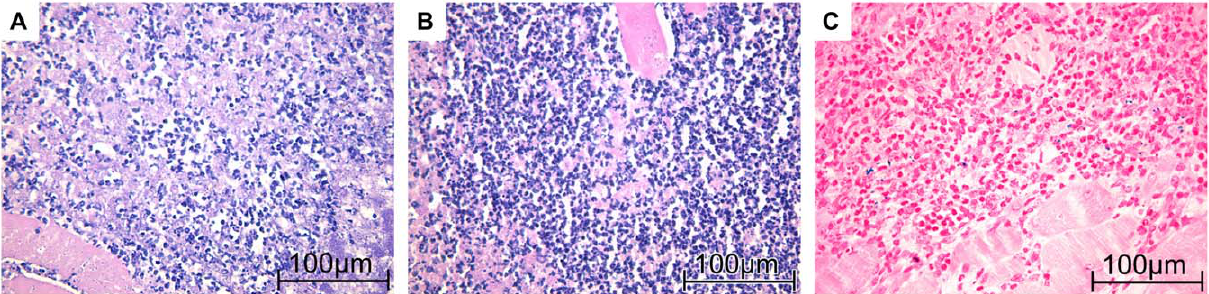
Figure 7. Histological appearance of chronic soft-tissue infection. A, C) Mice received CLIO at day 2 post infection. Images were recorded 24 h after administration. The muscle was recovered immediately after imaging. B) Mice received PFC at day 2 post infection and were imaged 24 h after administration. The muscle was recovered immediately after imaging. A) Macrophages and Granulocytes are embedded in granulation tissue at the abscess rim of CLIO group mice. C) Iron-specific staining demonstrates iron deposits in granulocytes and macrophages (iron appears blue). B) HE- staining of PFC group mice reveals macrophages and granulocytes in fibroblast-enriched granulation tissue similar to CLIO group mice.